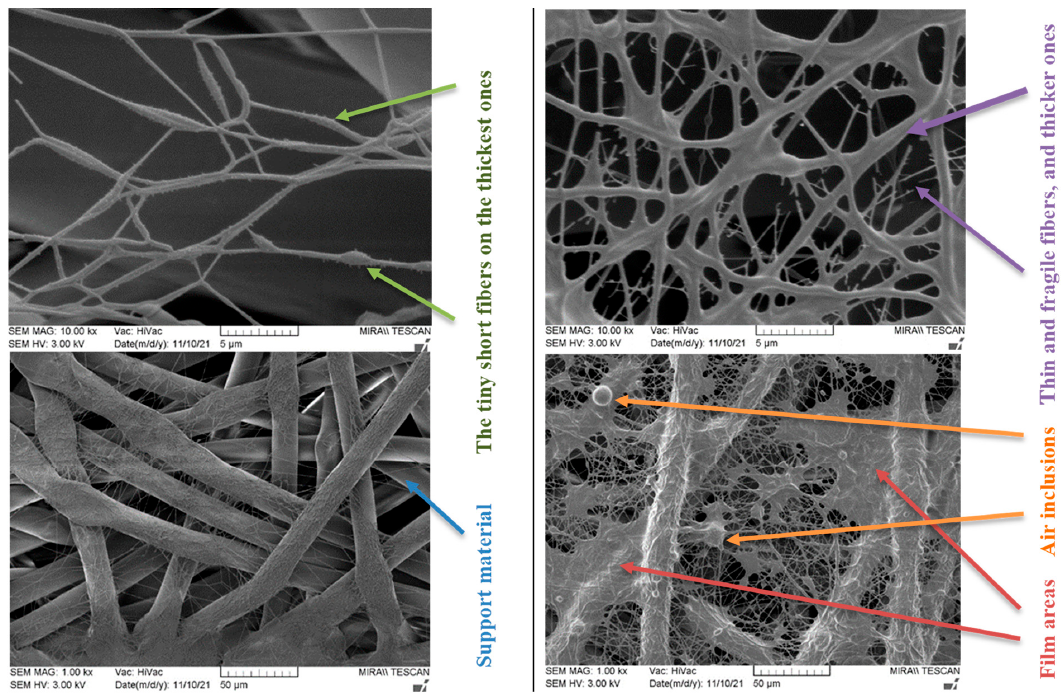
Figure 6. Electrospun membranes of sample 6PVA130 at an electrode distance of 150 mm using pike-type (left side) and needle-type (right side) electrodes.